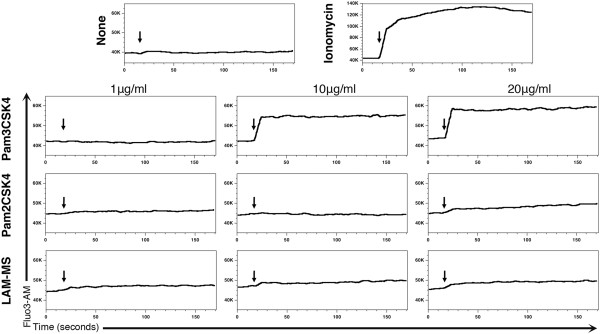
Pam3CSK4 triggers intracellular Ca2+ influx. Cultured TCM were loaded with the Ca2+ dye Fluo3-AM and cells were tested for their ability to increase intracellular calcium levels after treatment with ionomycin, or with increasing concentrations of Pam3CSK4, Pam2CSK4 or LAM-MS by flow cytometry. The arrows indicate when the stimuli were added. Data is representative of two donors.